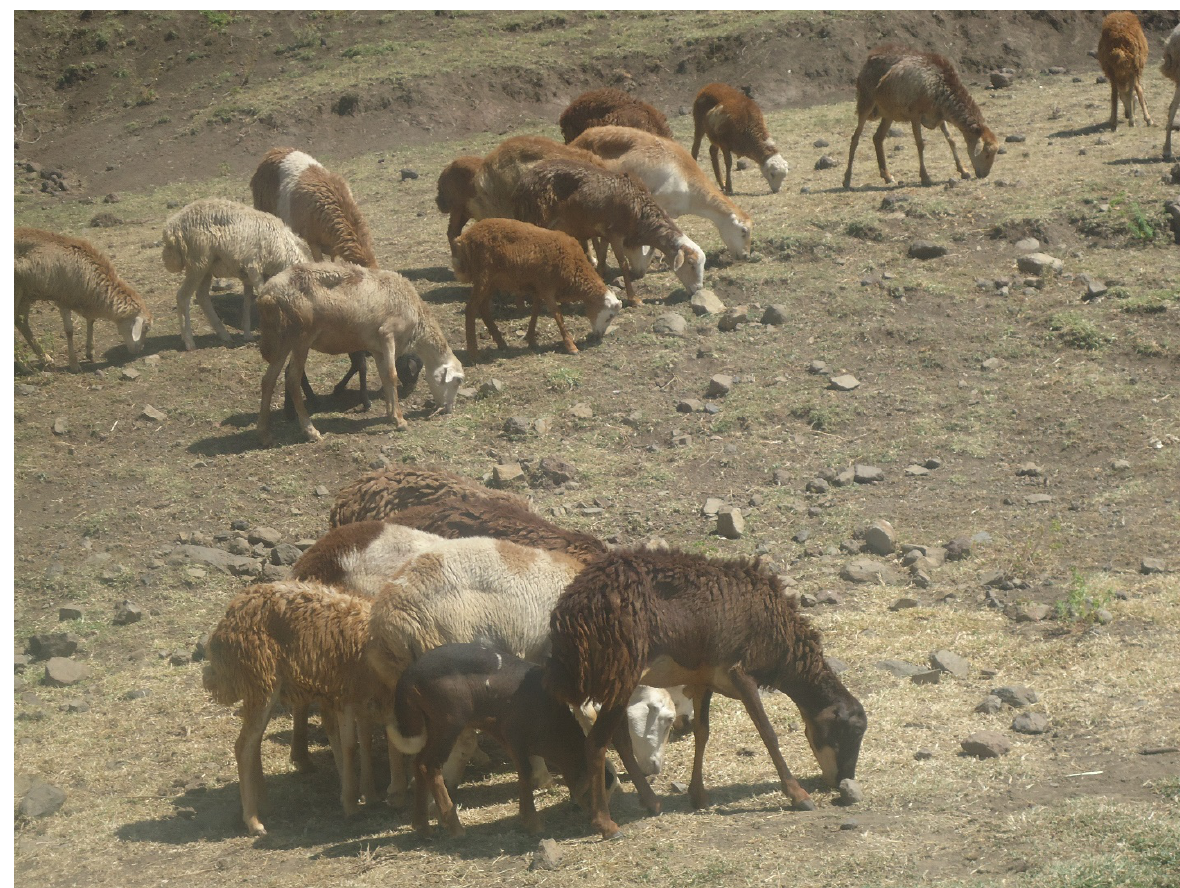
Figure 7. Highland sheep flock in Tahtay Maichew